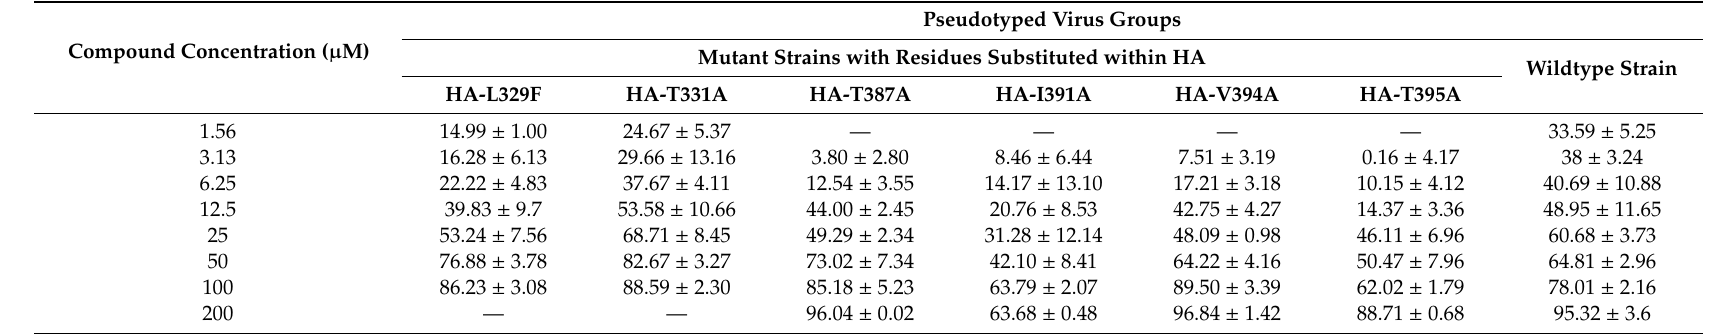
Table 4. The inhibitory rates of XC-27-1 against mutant H5N1 pseudotyped viruses (%) (x ± S, n = 3).